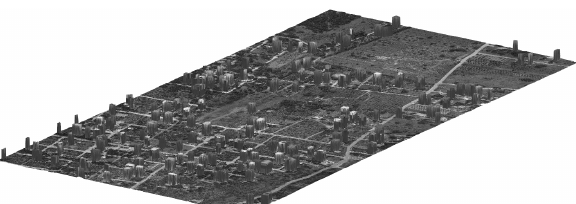
Figure 5: The detected buildings in 2D and 3D after the applica- tion of the developed